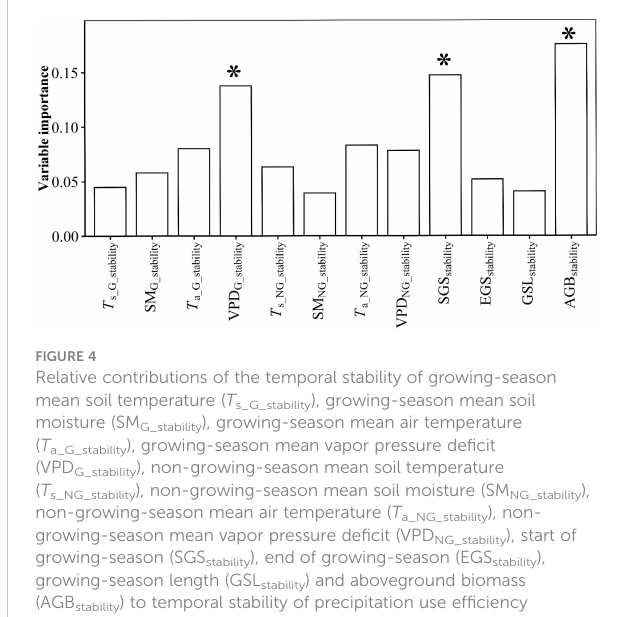
FIGURE 4 Relative contributions of the temporal stability of growing-season mean soil temperature ( T s_G_stability ), growing-season mean soil moisture (SM G_stability ), growing-season mean air temperature ( T a_G_stability ), growing-season mean vapor pressure de fi cit (VPD G_stability ), non-growing-season mean soil temperature ( T s_NG_stability ), non-growing-season mean soil moisture (SM NG_stability ), non-growing-season mean air temperature ( T a_NG_stability ), non- growing-season mean vapor pressure de fi cit (VPD NG_stability ), start of growing-season (SGS stability ), end of growing-season (EGS stability ), growing-season length (GSL stability ) and aboveground biomass (AGB stability ) to temporal stability of precipitation use ef fi ciency (PUE stability ). * indicates this variable had a signi fi cant in fl uence on PUE stability at p <0.05